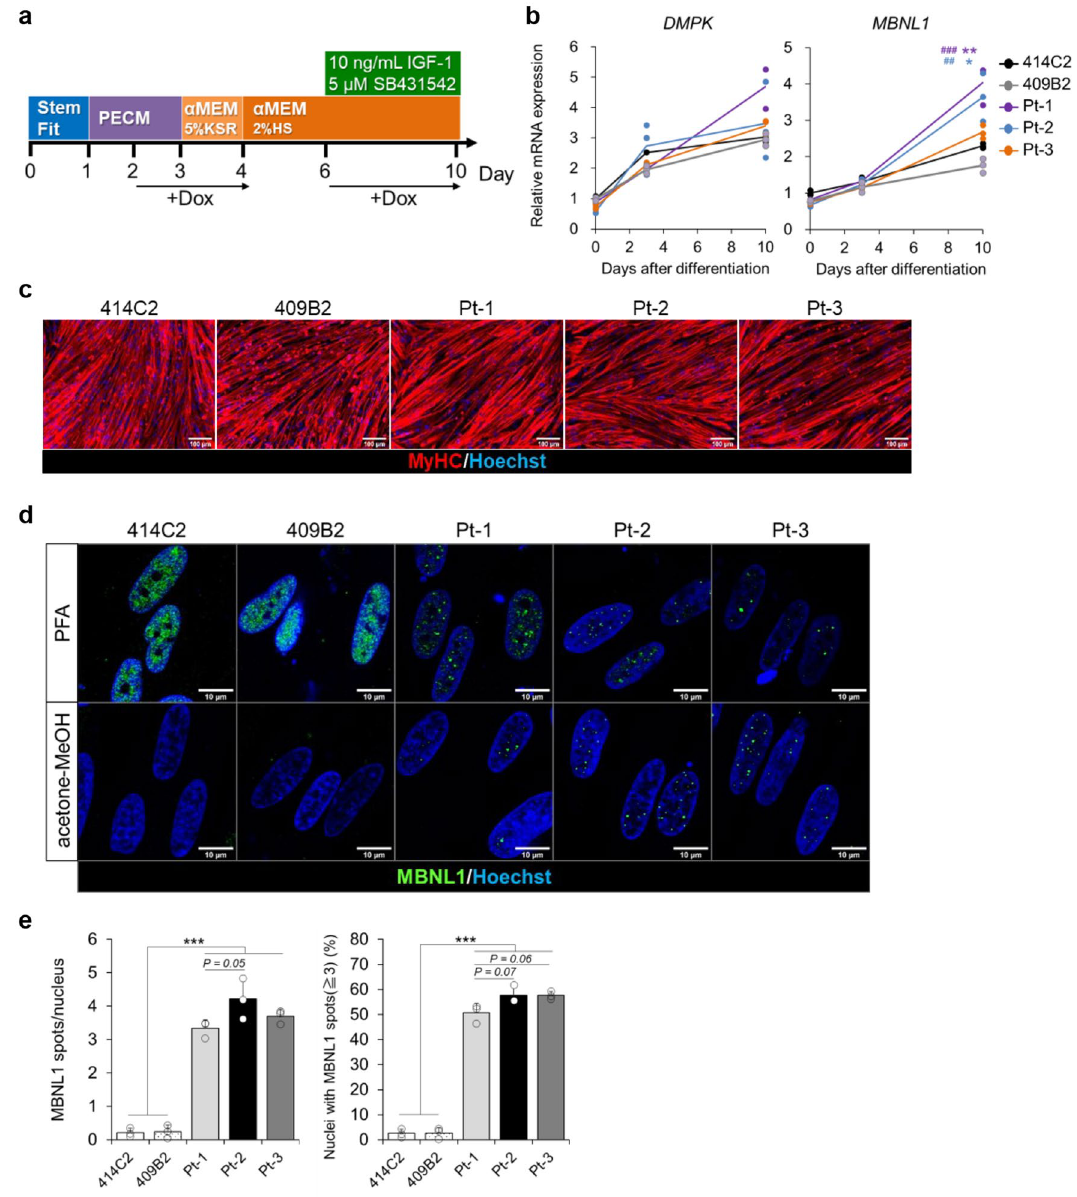
Figure 1. Nuclear MBNL1 aggregation in the myotubes differentiated from MyoD-DM1-hiPSCs. ( a ) A schematic protocol of the MyoD1-induced differentiation for 10 days, with reference to our previous report 18 . ( b ) Time-course of mRNA expressions of the DM1-related genes, DMPK and MBNL1 by RT-qPCR analyses on day 0, day 3 and day 10 of differentiation. The gene expressions are indicated by relative values to 414C2 control on day 0. The data represent the means of three independent experiments and were analyzed by one- way ANOVA followed by Tukey’s test (* P < 0.05, ** P < 0.01, vs. 414C2 control and ## P < 0.01, ### P < 0.001, vs. 409B2 control). ( c ) The representative immunohistochemistry images for MyHC and Hoechst on day 10. Scale bars, 100 μm. ( d and e ) Evaluation of nuclear MBNL1 aggregation on day 10. ( d ) Representative immunohistochemistry images after PFA or acetone-MeOH fixation for MBNL1 and Hoechst. Scale bars, 10 μm. ( e ) Quantitative analyses of the images of MBNL1 immunostaining after acetone-MeOH fixation using the ImageJ software. The nuclear regions were detected by Hoechst counterstaining. Data represent the means + SD of three independent experiments and were analyzed by one-way ANOVA followed by Tukey’s test (*** P <